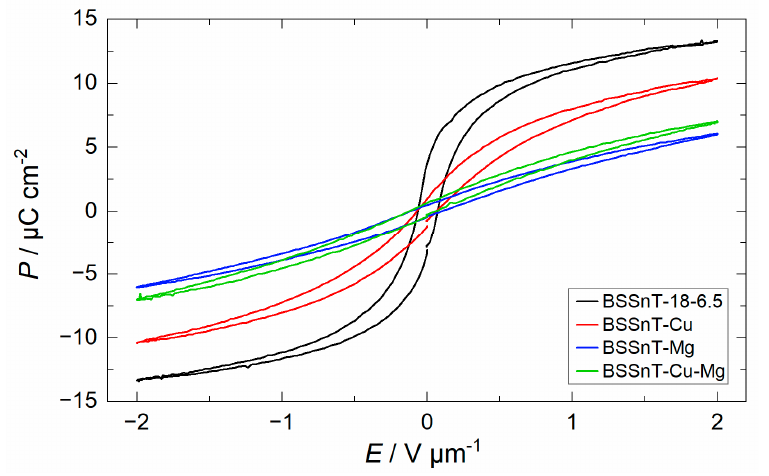
Figure 8. Hysteresis loops for BSSnT-18-6.5 with di ff erent additives measured at 20 °C and 10 Hz. Table 3. Compilation of maximum polarization ( P m ), remanent polarization ( P r ) and coercive field E c for BSSnT-18-6.5 with di ff erent additives (measured at 10 Hz, 2 V µm − 1 ).